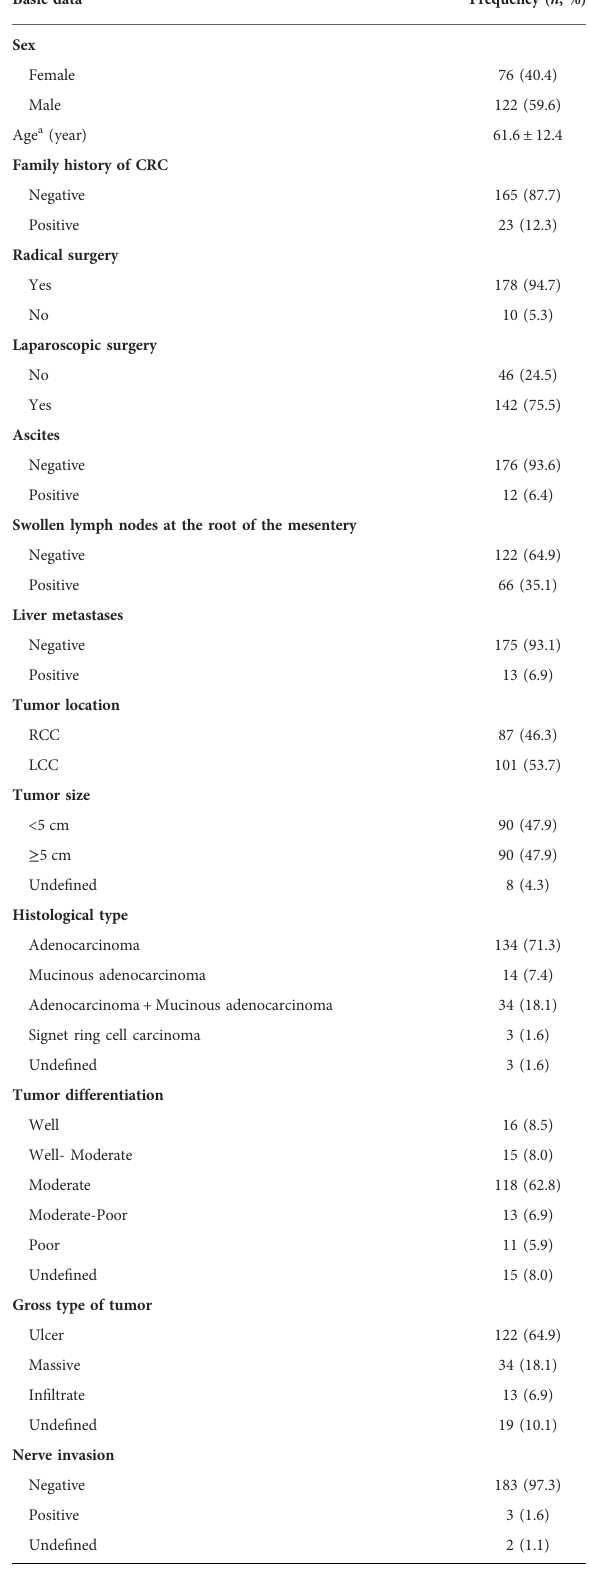
TABLE 1 Basic data for patients with colon cancer. Basic